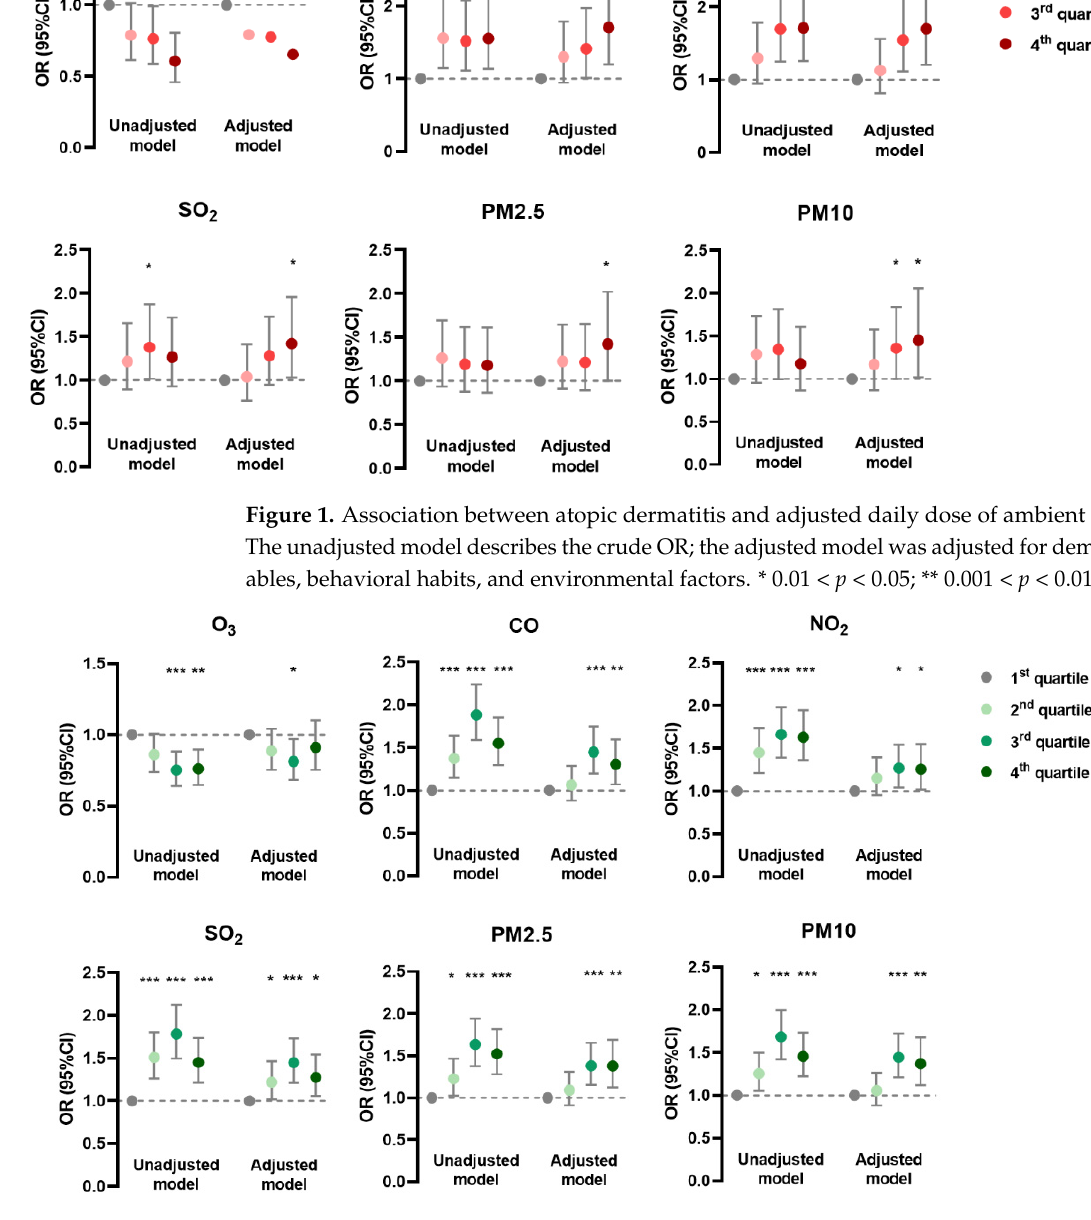
Figure 3. Association between urticaria and adjusted daily dose of ambient air pollutants. The un- adjusted model describes the crude OR; the adjusted model was adjusted for demographic varia- bles, behavioral habits, and environmental factors. * 0.01 < p < 0.05; ** 0.001 < p < 0.01; *** p < 0.001. The association of second-hand smoke (SHS) with AD, CHE, and urticaria was ana- lyzed. Notably, a higher frequency of SHS exposure was positively correlated with the prevalence of all three diseases (Table 3). Other covariates including sex, family income, BMI, and bath frequency for AD, CHE, and urticaria are shown in Table S2.